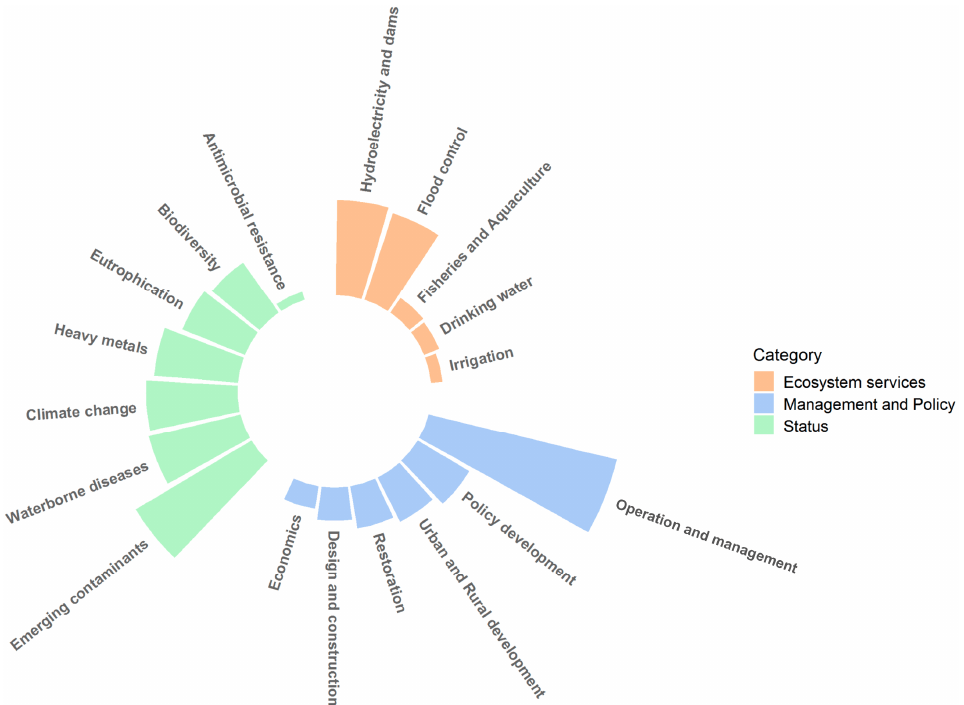
Figure 1. The number of publications in three research lines with topics related to the sustainable development of lakes and reservoirs from 2009 to 2018. The data were extracted from the online database of the Science Citation Index Expanded (SCI-Expanded) in the Web of Science on 24 January 2019. More information on the methodology of the bibliometric analysis can be found in Supplementary Material A.